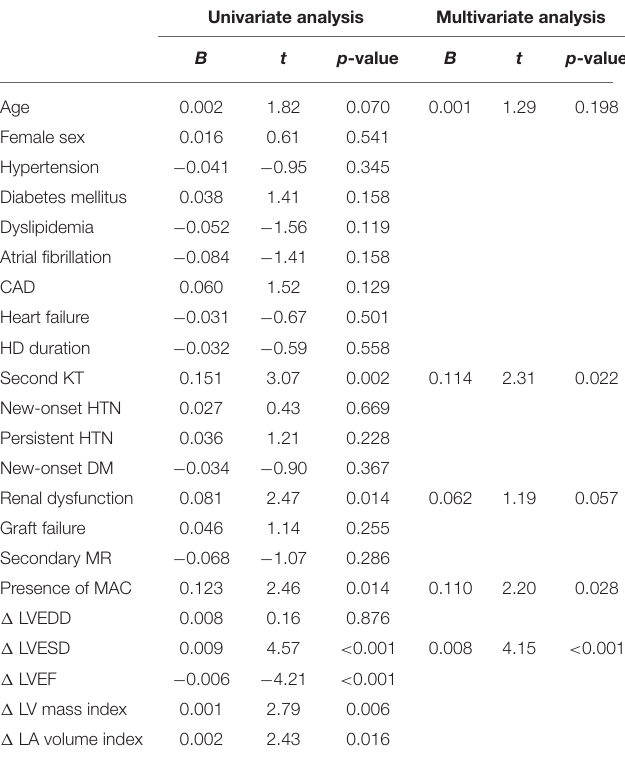
TABLE 3 | Factors associated with progression of mitral regurgitation after KT.